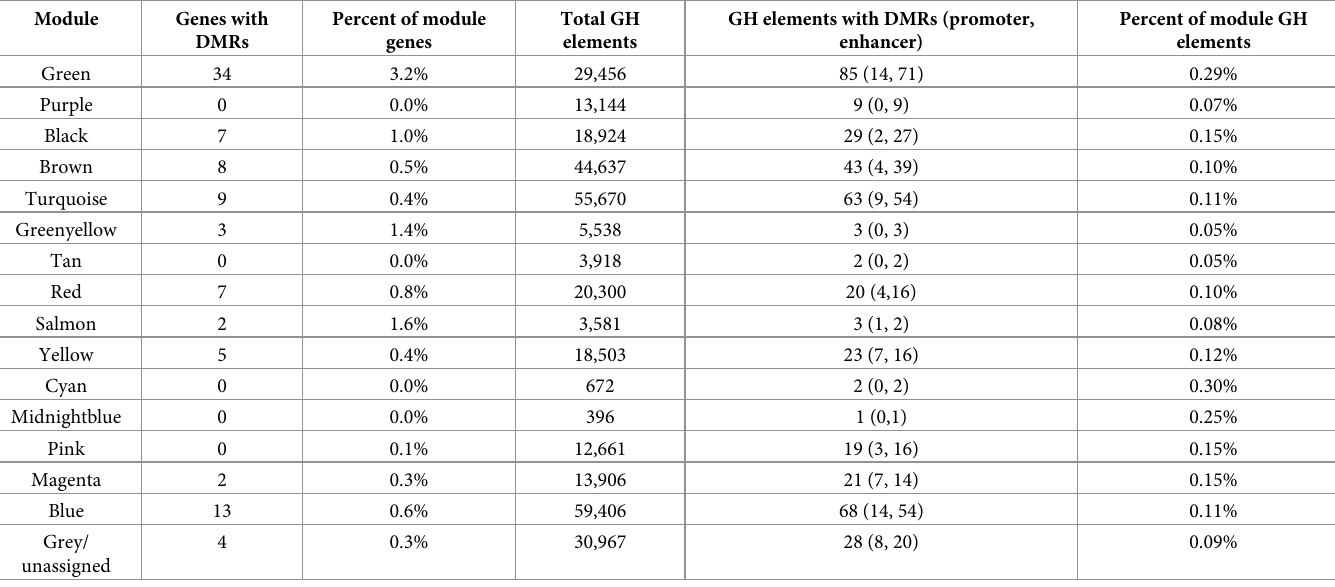
Table 2. DMRs and their relationship to genes and GH elements in WGCNA modules.